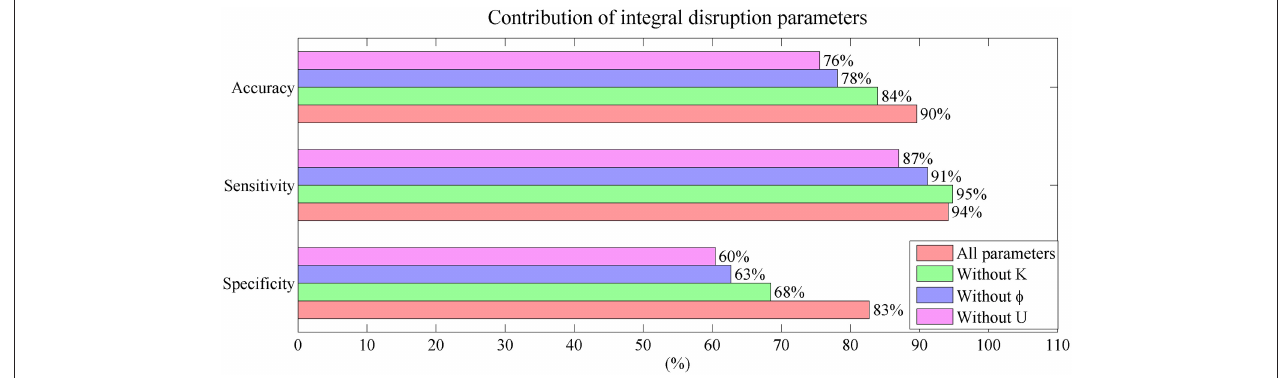
FIGURE 8 | Mini network integral disruption parameters’ contribution to the performance in